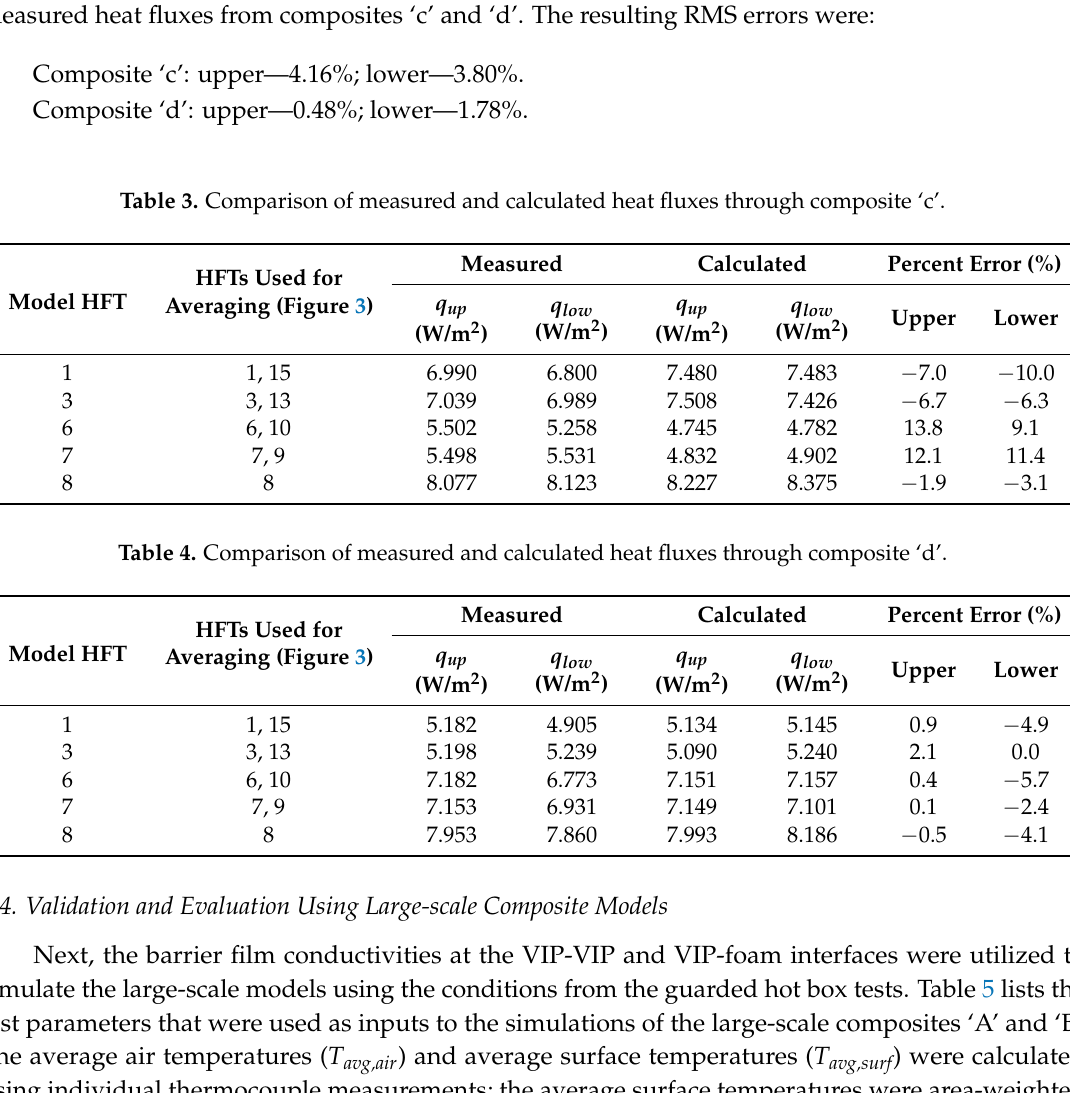
Table 3. Comparison of measured and calculated heat fluxes through composite ‘c’.